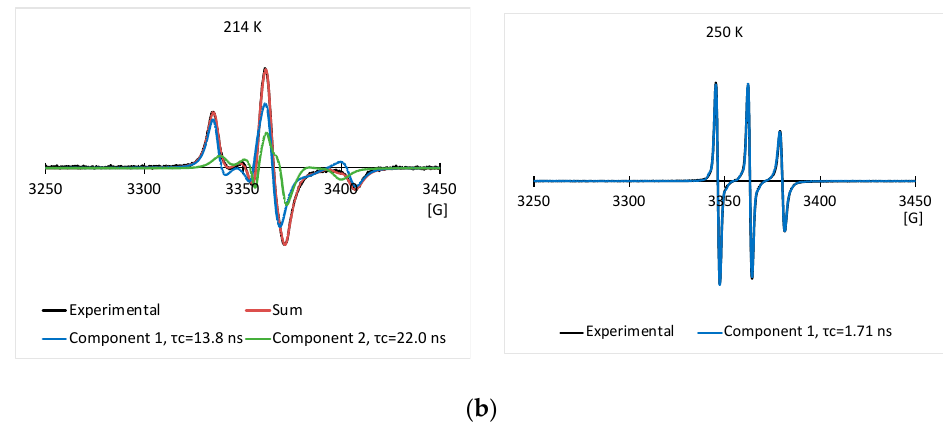
Figure 3. Typical experimental EPR spectra and their simulated EPR spectra of the 2.0 mg/mL spin labeled L23C in the 5% glycerol solution through the freezing process ( a ), and melting process ( b ), respectively.